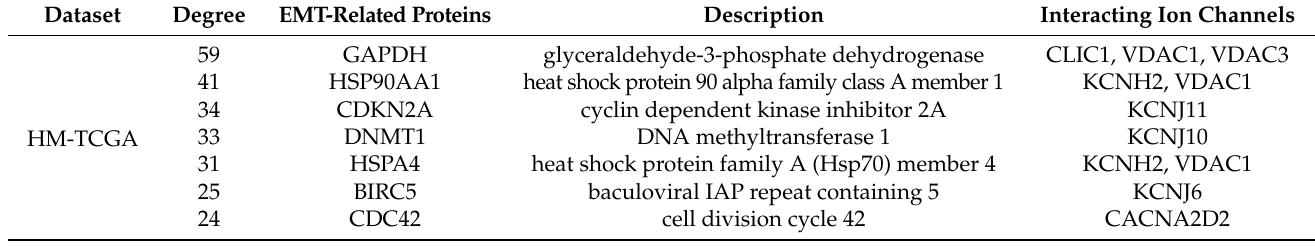
Table 8. A list of ion channels interacting with top 15 EMT-related proteins with the highest degree centrality measure in protein–protein interaction networks of modules on HM DEGs in breast cancer TCGA dataset.